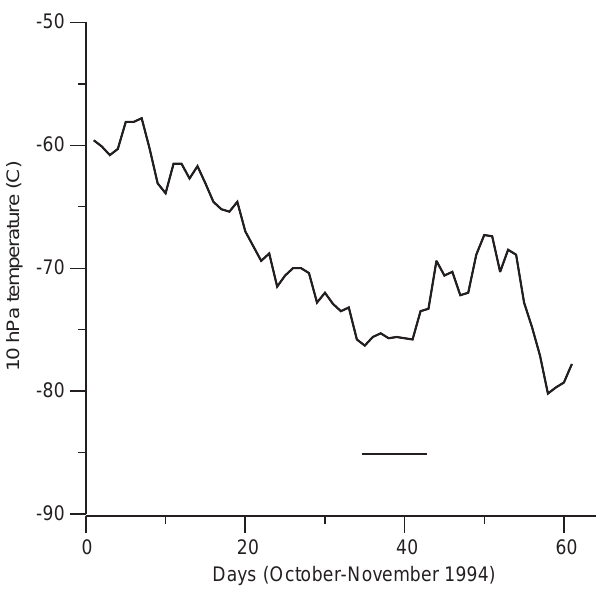
Fig. 3. Parameter f from Wakkanai ( solid line ) and Okinawa min ( dashed line ) during October–November, 1994 (days 1–61). Short horizontal line, interval of the